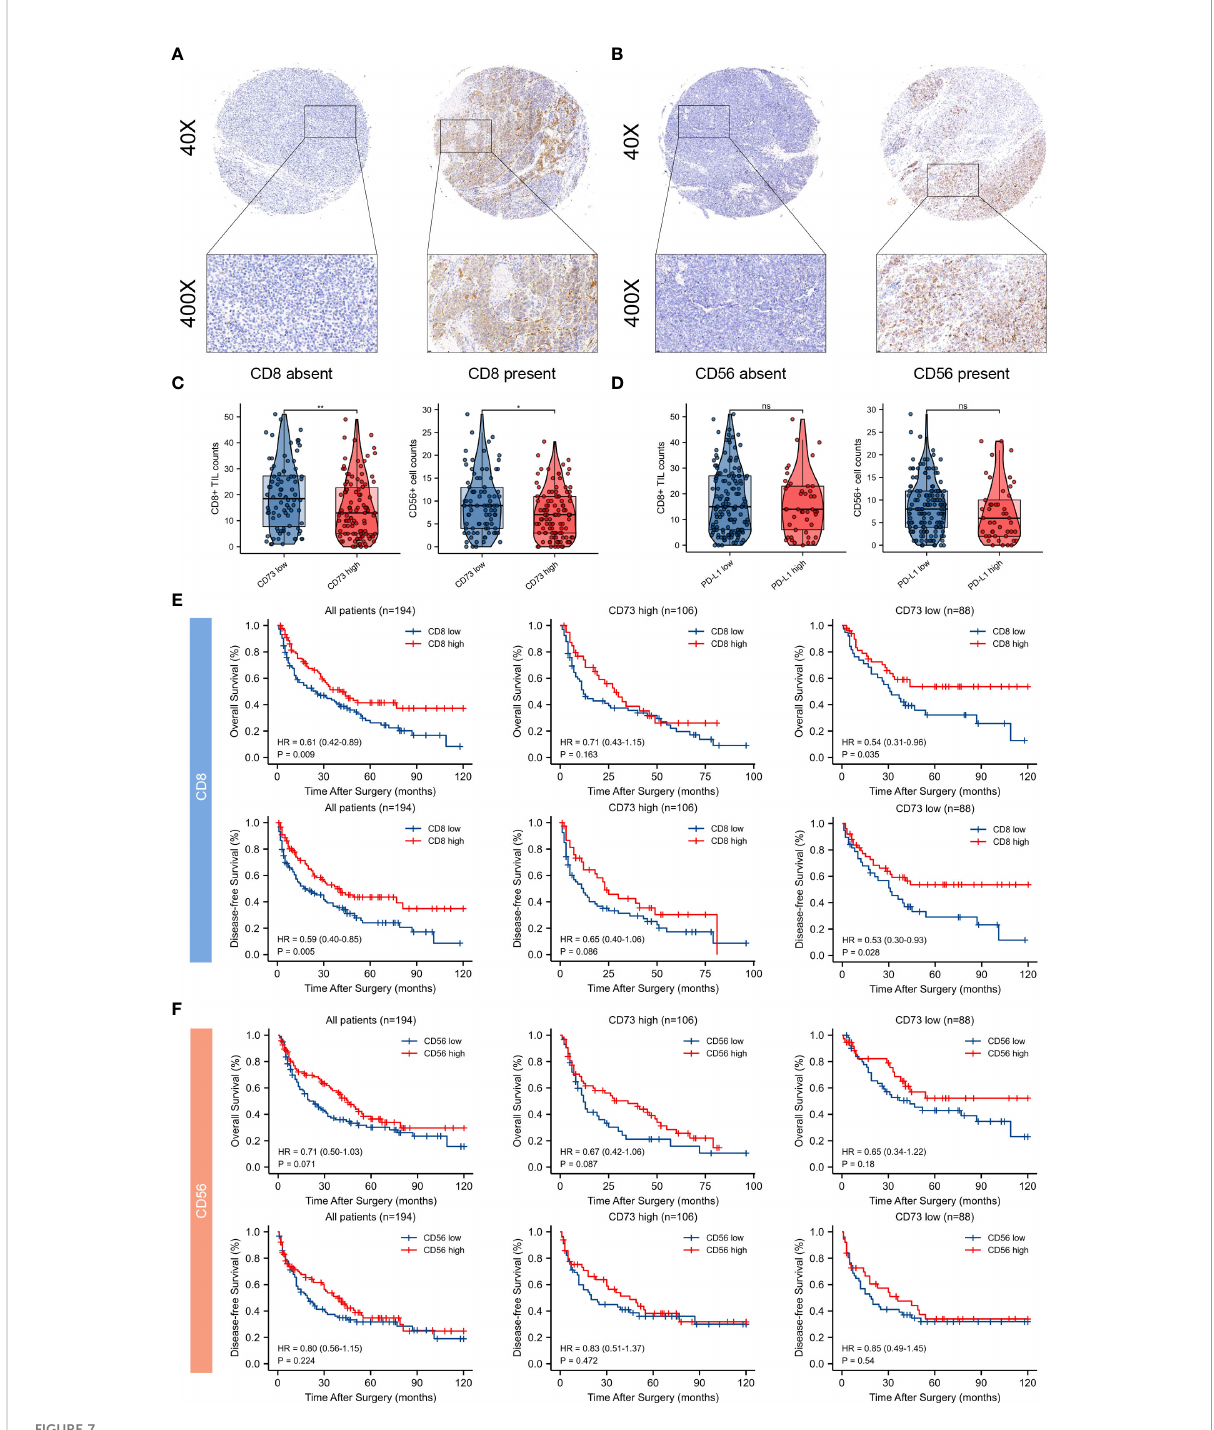
FIGURE 7 Tumor in fi ltrating CD8 + T cells and CD56 + NK cells and their correlations between CD73 and PD-L1 expression, and prognostic value of intratumoral immune cells in CD73 high and CD73 low subgroups. Typical micrographs of positive CD8 (A) , CD56 (B) staining and the corresponding intra-tumor negative controls. Original magni fi cation × 40 for full views and × 400 for detailed views. Scatter plots depicted the correlation between CD8 + T cells and CD56 + NK cells and CD73 expression. High CD73 expression. was signi fi cantly correlated with lower intra-tumor counts of CD8 + T cells and CD56 + NK cells (C) . PD-L1 expression had no signi fi cant correlation with counts of CD8 + T cells and CD56 + NK cells (D) . Kaplan-Meier curves of OS and DFS in CD73 high and CD73 low subgroups according to CD8 + and CD56 + cells in fi ltration (E, F) . *p<0.05; **p<0.01; ns, no signi fi